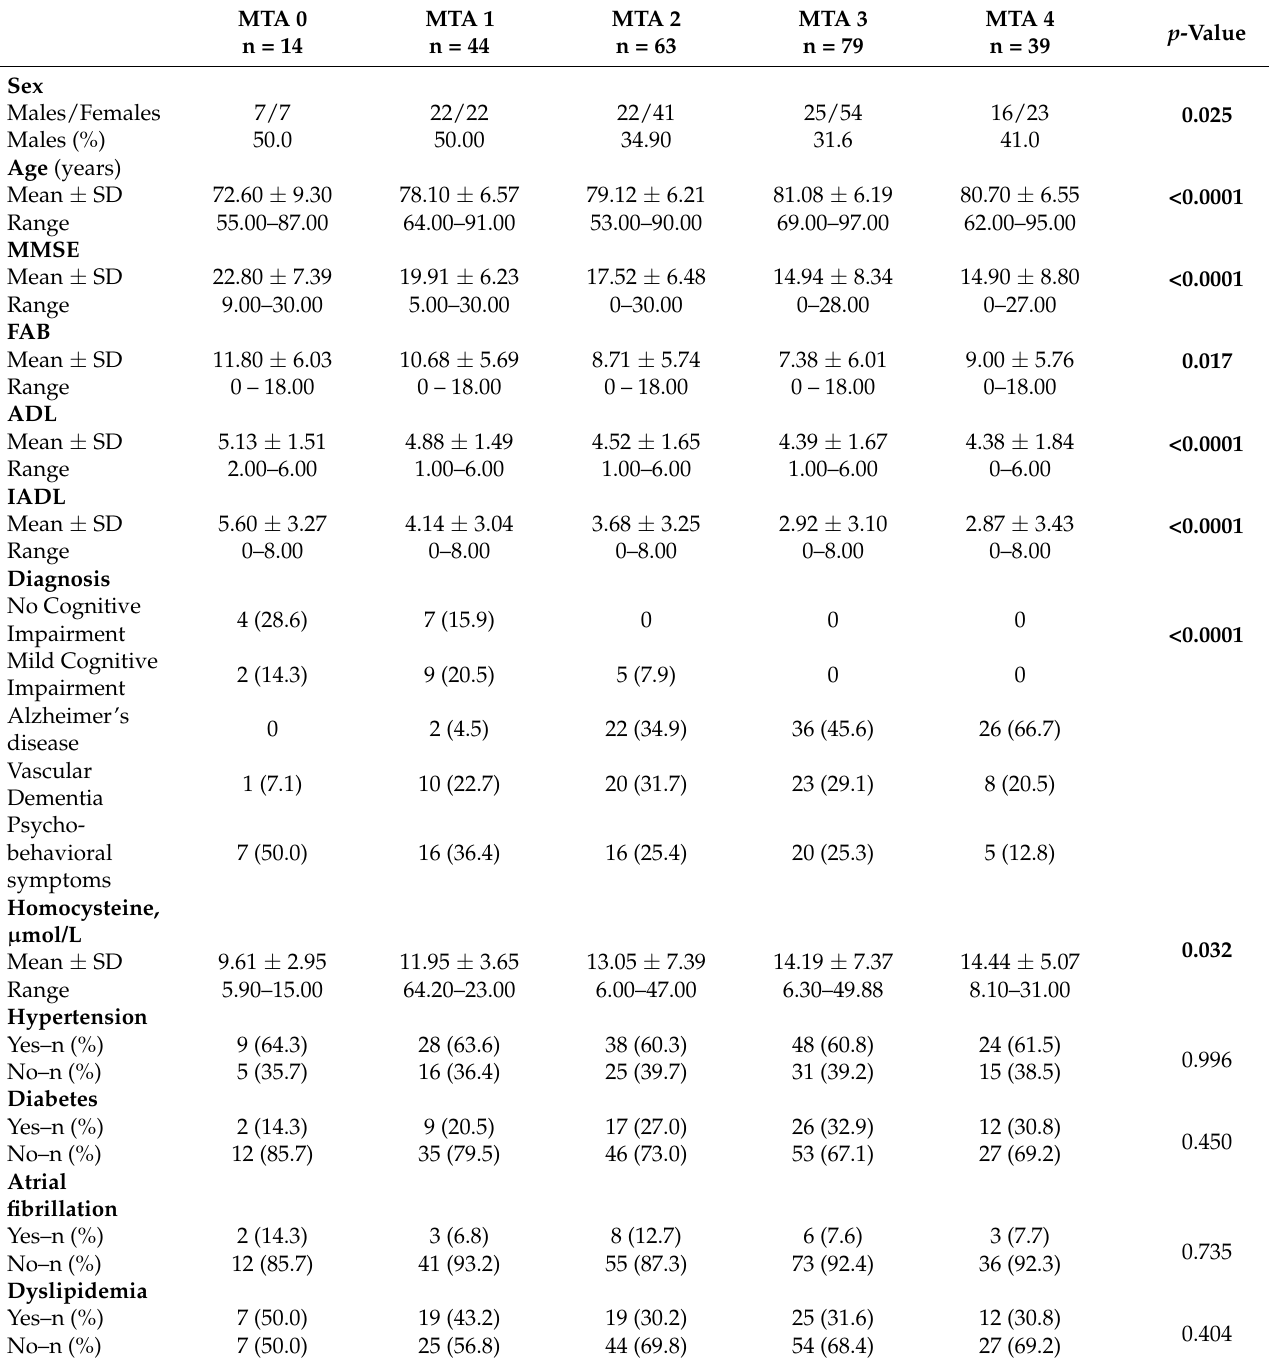
Table 1. Demographic, cognitive, functional, clinical, and biochemical characteristics of older patients according to MTA